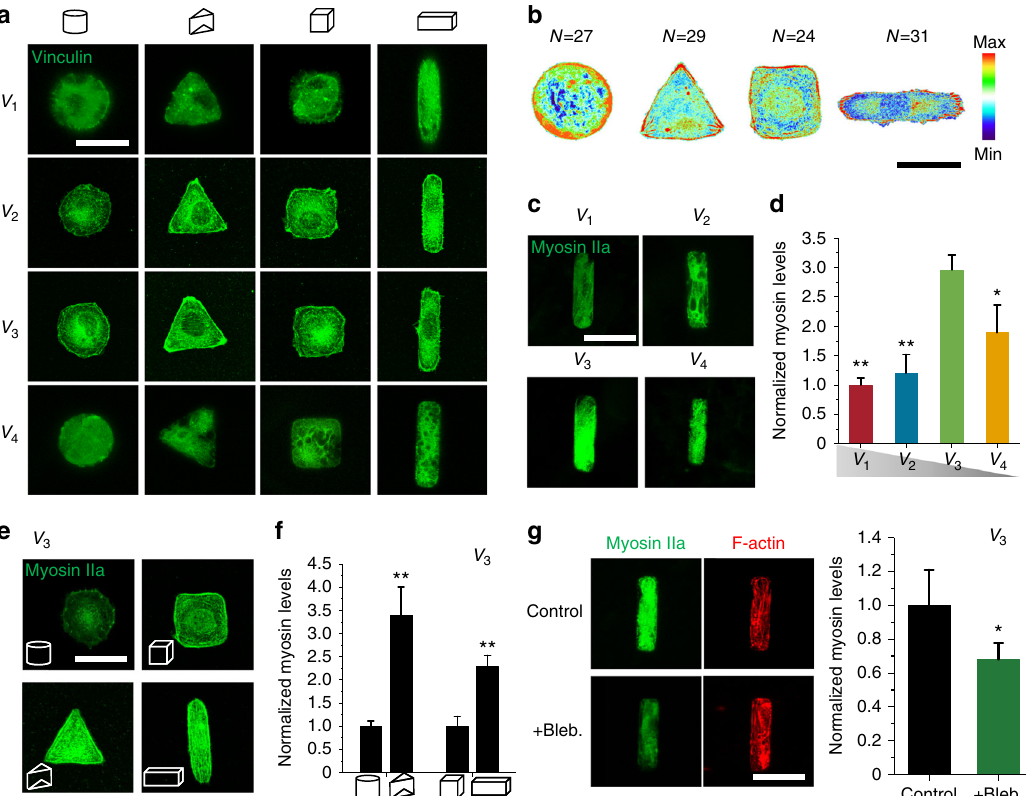
Fig. 3 Focal adhesions formation and cell tension in a 3D microniche. a Representative images of vinculin staining for single hMSCs cultured in 3D microniches with different volumes and geometries. b Fluorescent heat maps of ≥ 20 cells with the same volume ( V 3 ) but different geometries stained for vinculin. c Representative images of myosin IIa in cells of same geometry but different volumes. d Myosin IIa levels (per cell) as a function of cell volume. e Representative images of cells with different geometries but same volume ( V 3 ). f Myosin IIa levels as a function of cell shape (cylinder and triangular prism) or aspect ratio (cubic and cuboid). g Representative images of myosin IIa and F-actin before and after cells with V 3 treated with 50 μ M Blebbistatin (Bleb); bar graph shows quantitation of the changes in the level of myosin IIa after treatment with 50 μ M Blebbistatin (Bleb). Data are shown as mean ± s. d. for all panels; n = 45 – 60 cells analyzed for each data point and * P < 0.05, ** P < 0.01 (ANOVA using a Tukey post-test). Scale bar for all images is 20 μ